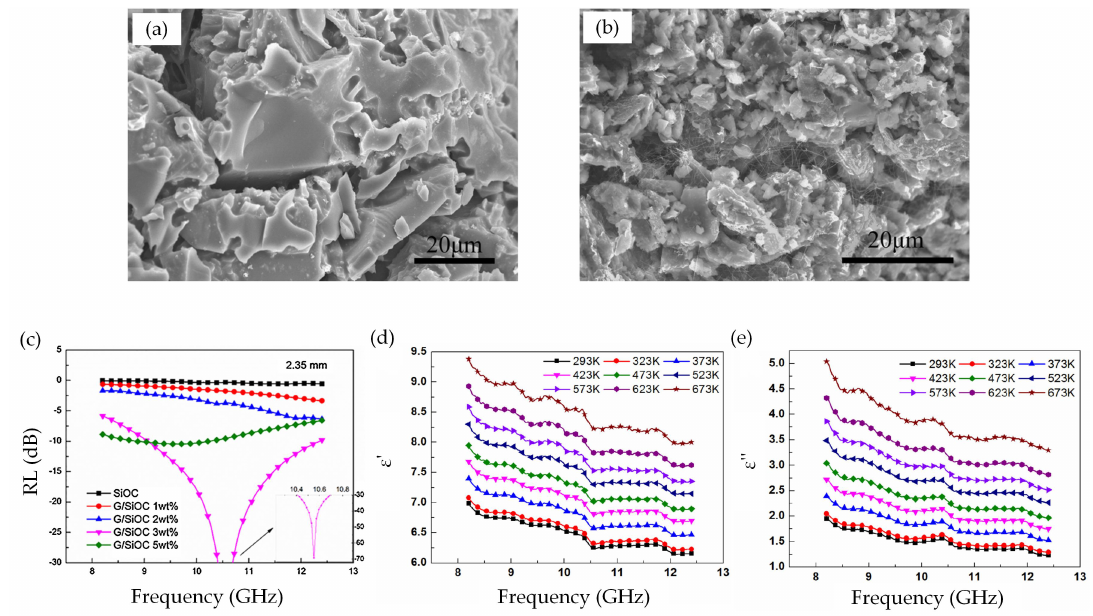
Figure 4. The SEM images of ( a ) SiOC ceramic and ( b ) G/SiOC ceramic; ( c ) the calculated RL spectra of Dällenbach absorber with G/SiOC synthesized under various amounts of graphene oxide. The measured ( d ) real and ( e ) imaginary parts of complex permittivity under various temperatures, reprinted with permission from Ref.